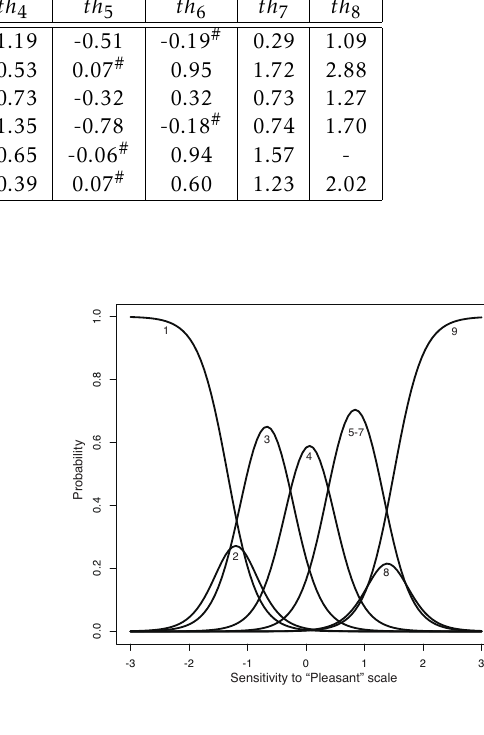
Figure 5. An example of category response curves (CRCs) using the probabilities for sub2 of “Pleasant” ratings in Figure 4. tests for all parameters, some tests were not significant.